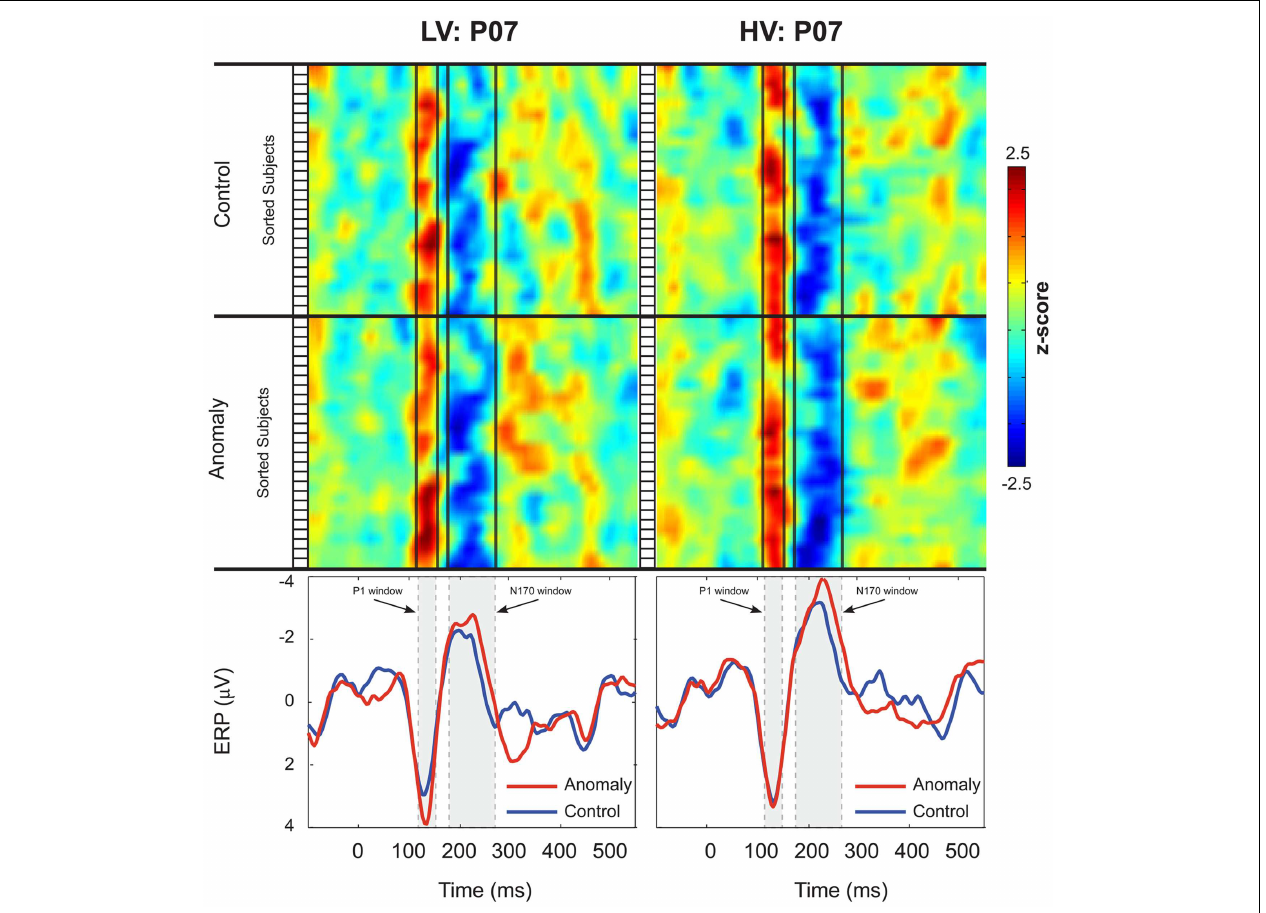
the left of each stack represent the boundaries for each subject in the map. Vertical black lines represent the boundaries for the P1 and N170 windows. The bottom panels of each column show the group averaged ERPs for each of the sentence-types. Shaded boxes represent the boundaries for the P1 and N170 windows. Scalp ERP waveforms are plotted negative